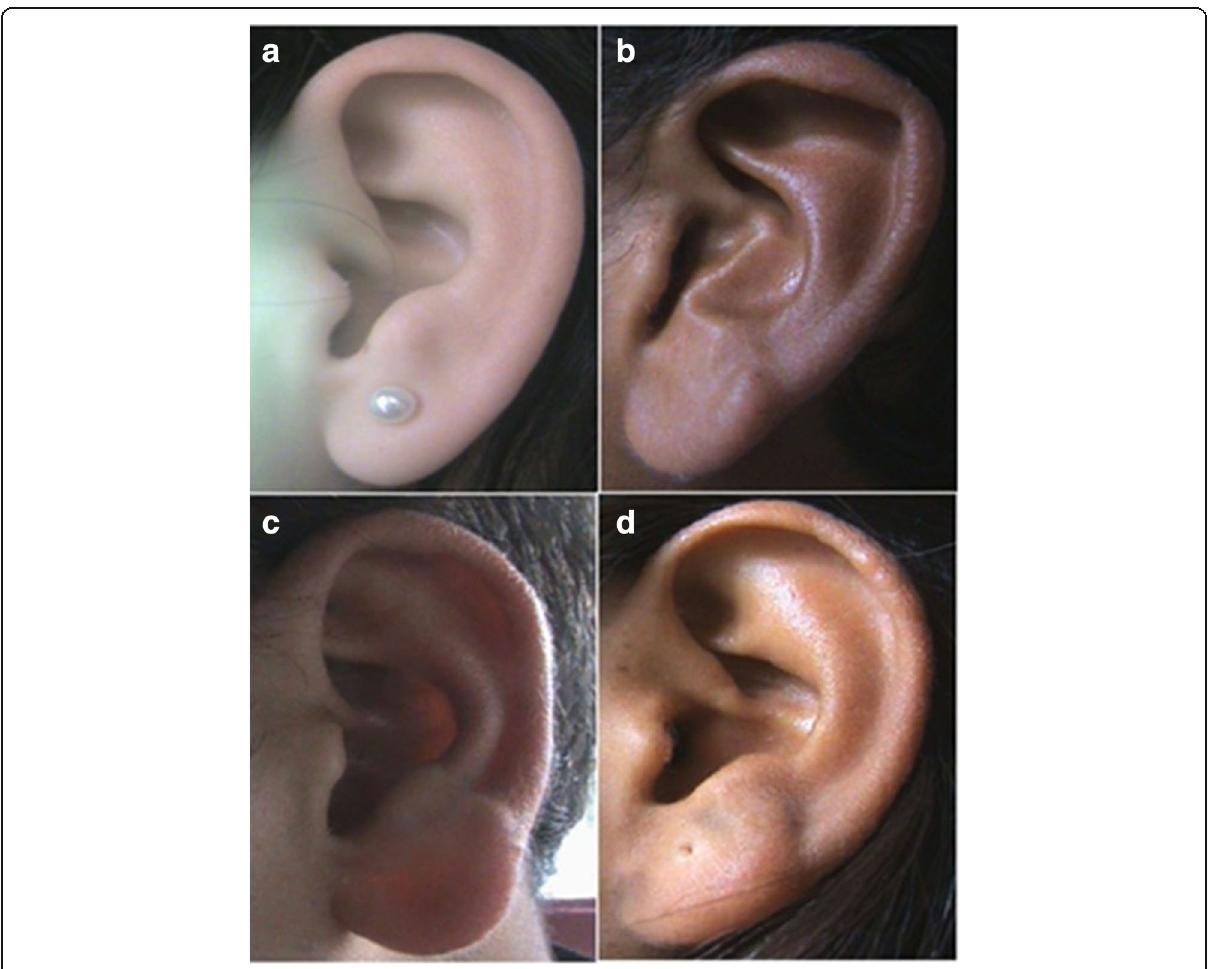
Fig. 2 Photographs showing the shape of the ear. a Oval. b Triangular. c Rectangular. d